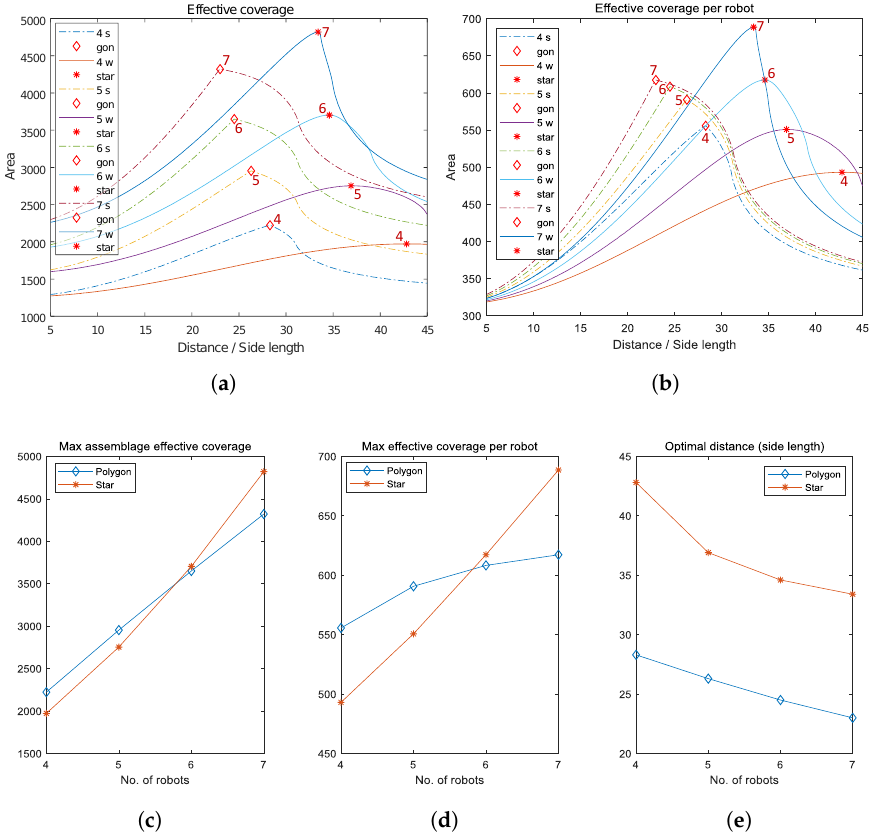
Figure 12. Plots of effective coverages of n -node teams equipped with model I ( d ) = β / d 2 , where n = 4,5,6,7. The team formations are in regular polygons ( (cid:5) ) and regular stars (*). ¯ r = 10. ( a ) Team’s effective coverage; ( b ) Effective coverage per node; ( c ) Maximum team’s effective coverage vs. The number of nodes; ( d ) Maximum effective coverage per node vs. The number of nodes; ( e ) Optimal distance (polygon side length) vs. The number of